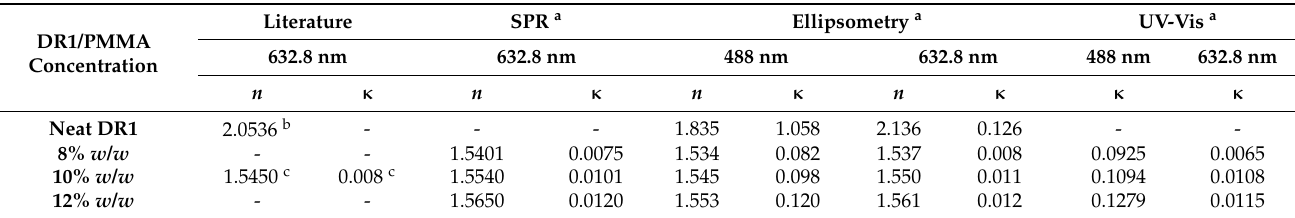
Figure 5. n and κ as a function of the wavelength for ( a ) neat DR1, ( b ) 8% w / w DR1/PMMA, ( c ) 10% w / w DR1/PMMA, and ( d ) 12% w / w DR1/PMMA. The film’s thickness was d ∼ 58 nm. Table 1. Optical Constants of neat DR1 and thin films of DR1/PMMA at 488 nm and 632.8 nm. The precision of the measured data by spectroscopic ellipsometry and SPR is 2 × 10 − 3 and 4 × 10 − 4 for n , and 4 × 10 − 3 and 1 × 10 − 4 for κ ,